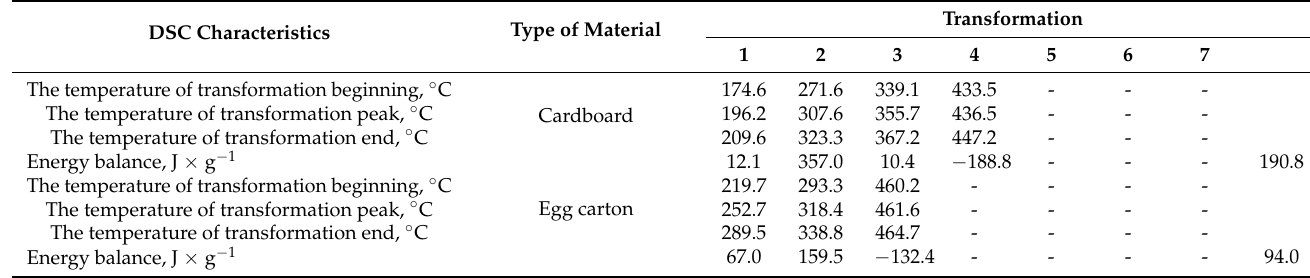
Figure 4. Characteristics of the DSC of cardboard waste: ( a ) cardboard; ( b ) egg cardboard. Table 4. Normalized transformation energy for successive transformations of tested cardboard waste and energy balance of the